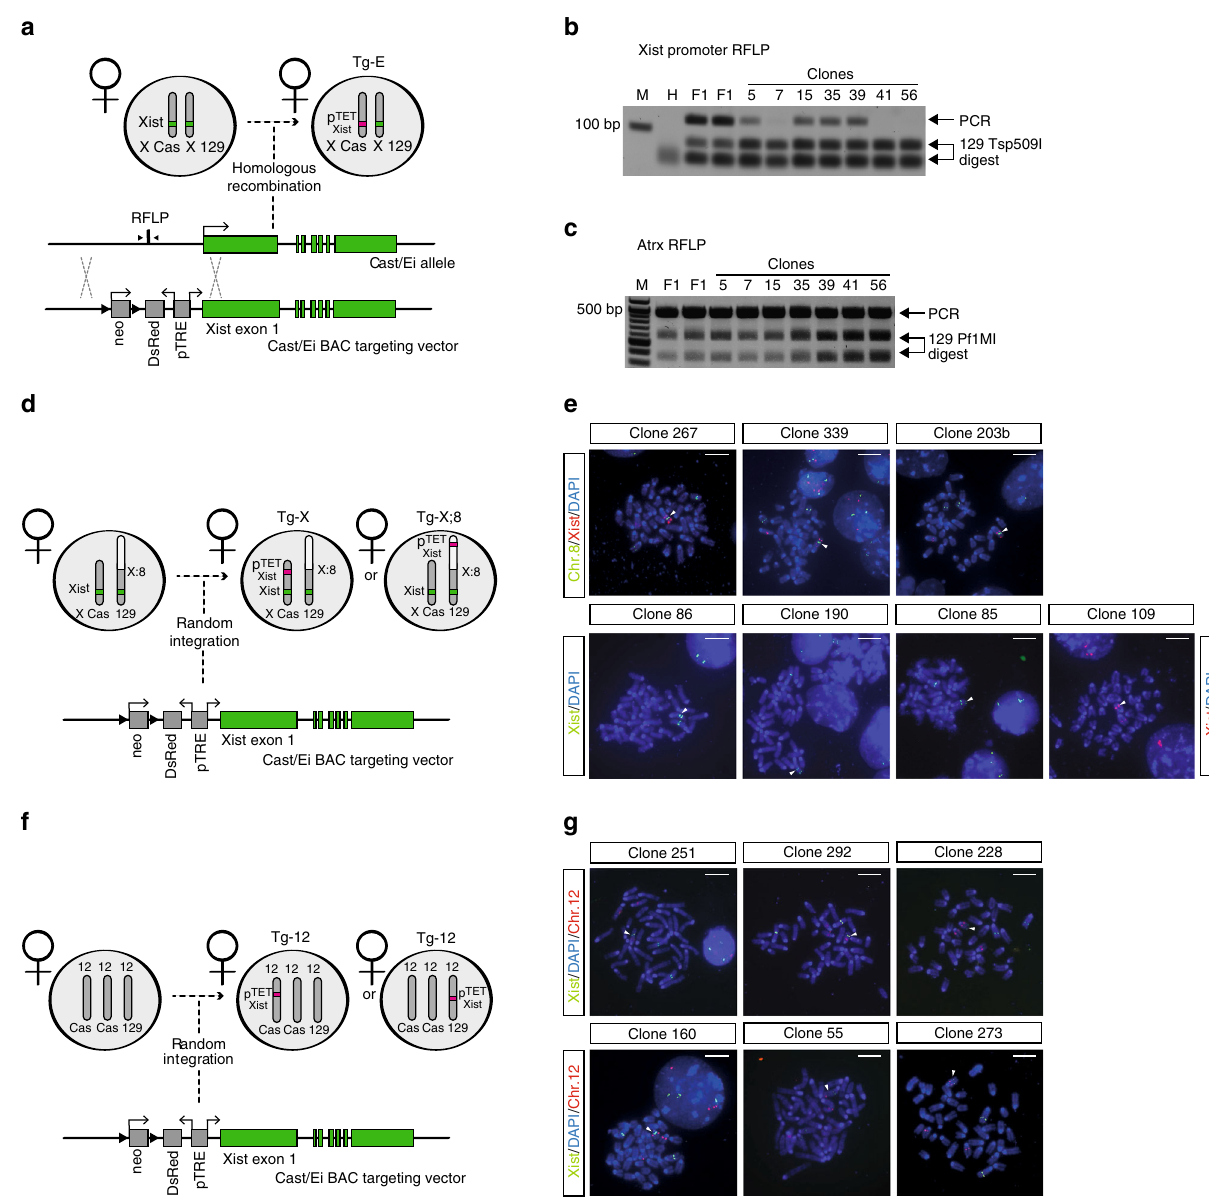
Fig. 1 Generation of a tetracycline-responsive Xist expression system in ES cells. a Targeting strategy to generate Tg-E clones. The Xist TSS was replaced with a bidirectional tetracycline-responsive Ptight promoter, a DsRed reporter gene, and a neomycin resistance cassette. b PCR ampli fi cation with primers indicated in a followed by a Tsp509I RFLP digest of PCR product to identify clones with a correctly targeted Cast/Ei allele. Correct targeting results in loss of Cast/Ei-speci fi c band, as shown for clones 7, 41, and 56. Arrows indicate size of PCR product and Tsp509I restriction fragments. F1 F1 2-1 polymorphic 129/Sv-Cast/Ei mother cell line, M marker, H water. c PCR ampli fi cation of a fragment of the X-linked gene Atrx and Pf1 MI digest of the PCR product to verify the presence of two X chromosomes. Arrows indicate size of PCR product and size of Pf1 MI restriction fragments. d , f Schematic representation of the strategy used to generate Tg-X, Tg-X;8 d , and Tg-12 clones f . The Xist transgene was randomly integrated into F1 2-1 40,XX,t(X;8) or 41,XX,dup12 ESC lines and neomycin-resistant clones were screened by DNA FISH. e , g DNA FISH screening of Tg-X, Tg-X;8 e , and Tg-12 g clones. Arrows indicate the chromosome carrying the Xist transgene. Positive Tg-X;8 clones show co-localization of three DNA FISH signals on the translocated X;8 chromosome corresponding to the Xist endogenous locus, the ectopic transgene, and the chromosome 8 portion of the X;8 translocation. Three independent ES clones were generated (267, 339, 203b). Positive Tg-X clones show two DNA FISH signals on the wild-type Cast/Ei X corresponding to the endogenous Xist locus and to the ectopic transgene, respectively. Four independent ES clones were generated (86, 190, 85, 109). Positive Tg-12 clones show co-localization of two DNA FISH signals on one of the three copies of chromosome 12, corresponding to the Xist-inducible transgene and to chromosome 12, respectively. Six independent ES clones have been generated (251, 160, 273, 292, 55, 228). Scale bars represent 5 μ m X-linked genes are more ef fi ciently silenced than autosomes . 52 RNA-seq libraries including two biological replicates per clone To assess whether ectopic Xist RNA could trigger gene silencing in both doxycycline- treated and untreated conditions. Total independently of its genomic position, we performed RNA-seq RNA-seq reads were aligned to both the 129/Sv and the Cast/Ei analysis of Tg-E, Tg-X, Tg-X;8 and Tg-12 clones after 5 days of parental genomes and the abundance of allele-speci fi c reads was doxycycline treatment in undifferentiated ESCs. We generated estimated by summing up the number of 129- and Cast-speci fi c NATURE COMMUNICATIONS | 8: